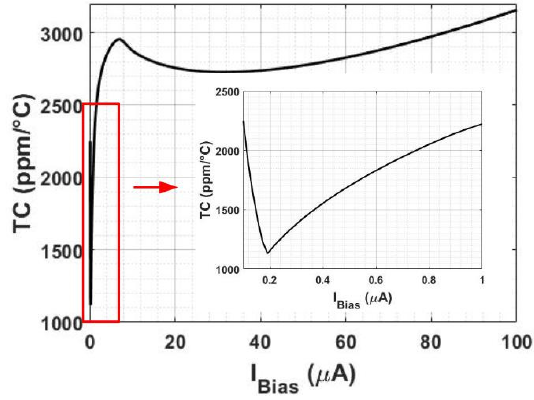
Figure 8. The TC of SCCT1 as a function of I BIAS.